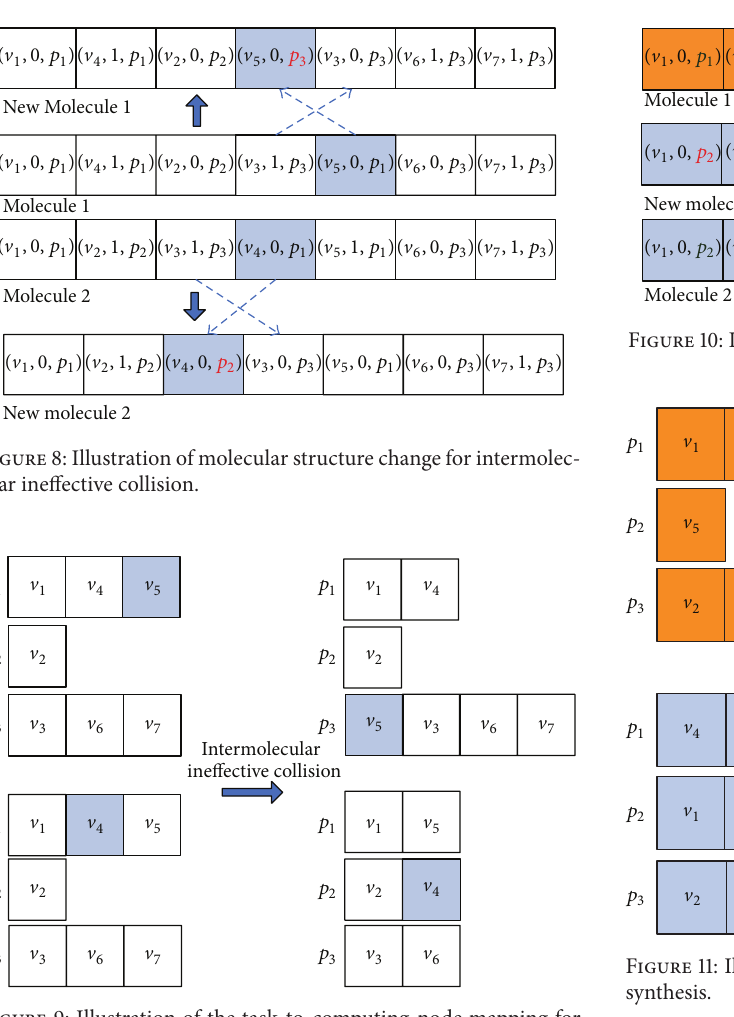
Figure 9: Illustration of the task-to-computing-node mapping for intermolecular ineffective collision.